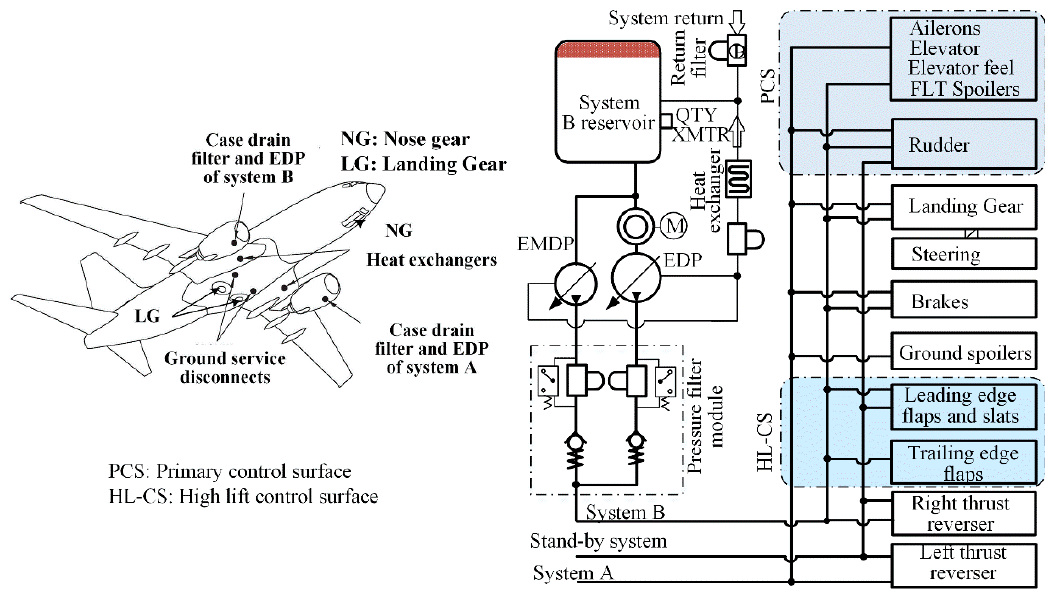
Figure 1. The layout of the primary components of the airliner hydraulic